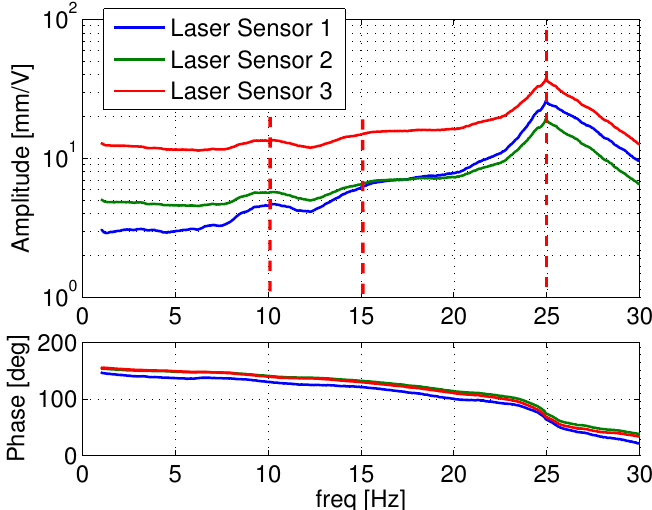
Figure 10. Frequency Response Function of the